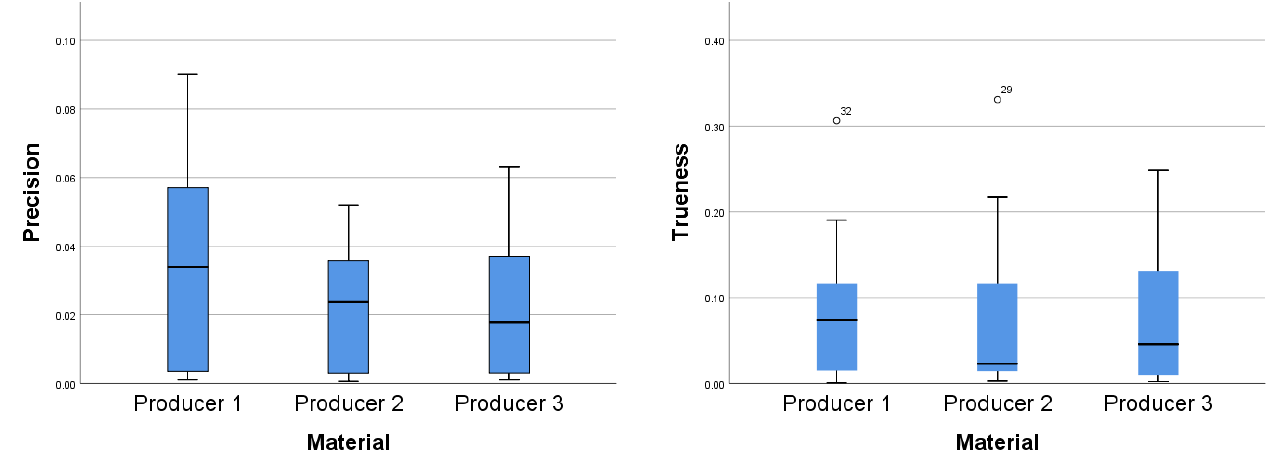
Figure 8. Distributions of precision values ( left ) and trueness values ( right ) for arch distances between the three material groups.